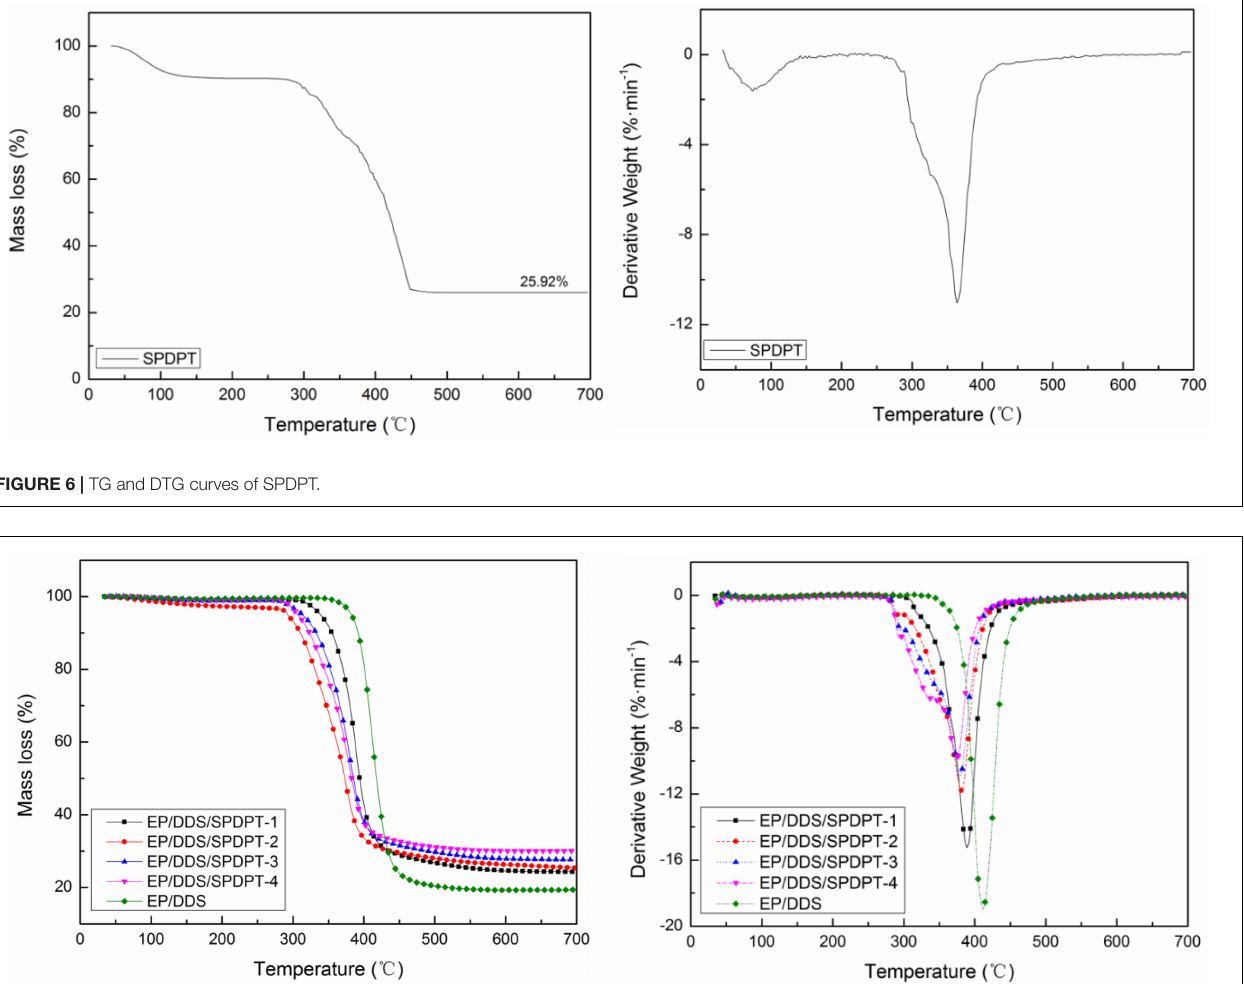
FIGURE 7 | TG and DTG curves of epoxy